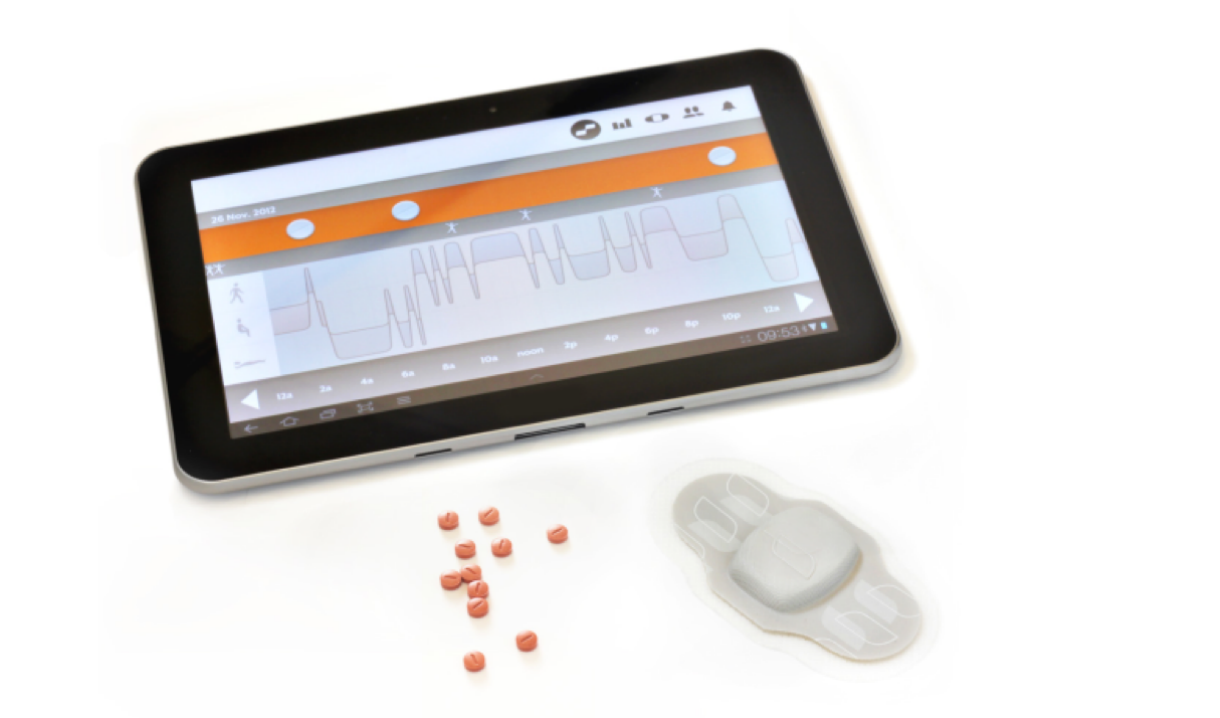
Figure 2. On-screen representation of the device’s scheduled dosing table. Each sensed dosing event is represented by an orange pill in each cell. Columns correspond to days of the week and rows to each scheduled dosing event for that